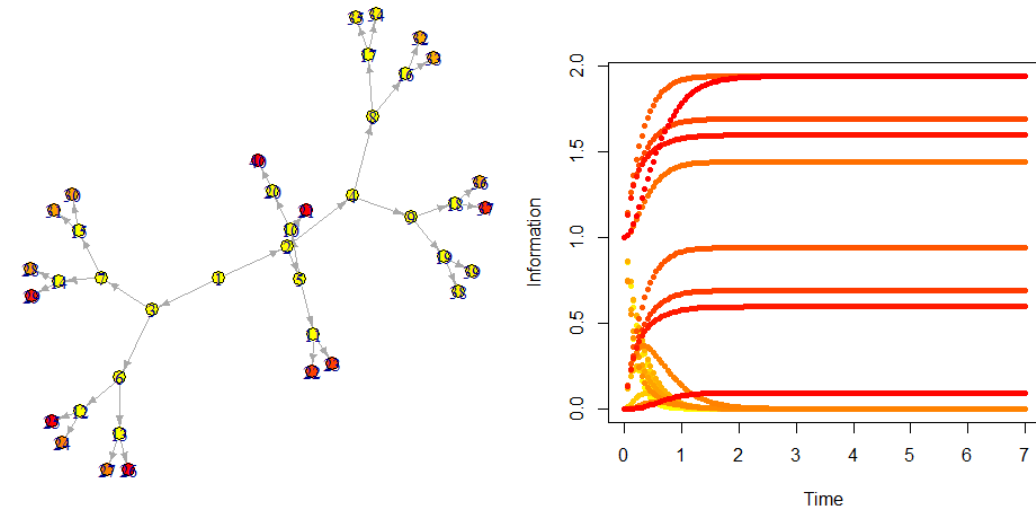
Figure 6. Diffusion on a directed binary